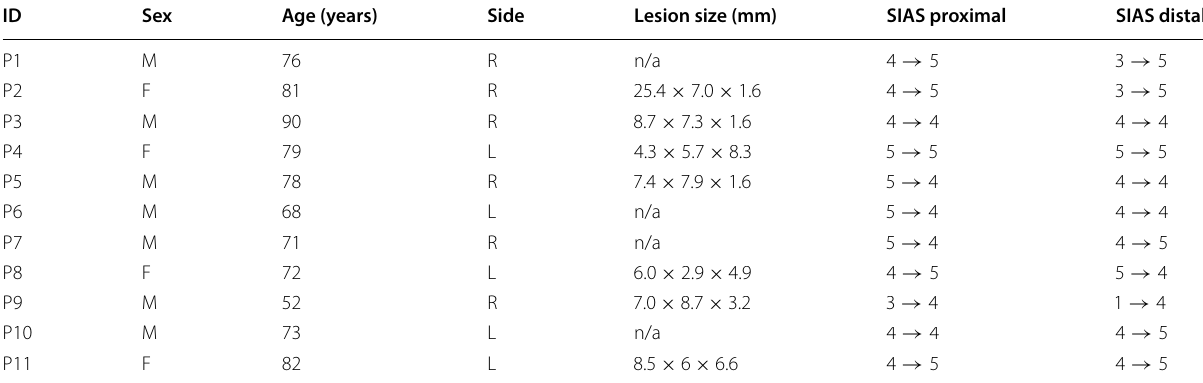
Side, affected hemisphere (left or right); SIAS Proximal and SIAS Distal, clinical assessments before and after all experiments,